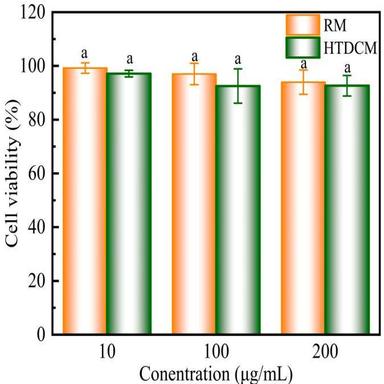
Cell viabilities after culture with different concentrations of RM and HTDCM extracts as determined by CCK-8 assay. Means with the same letter (a) are not significantly different (P < 0.05).